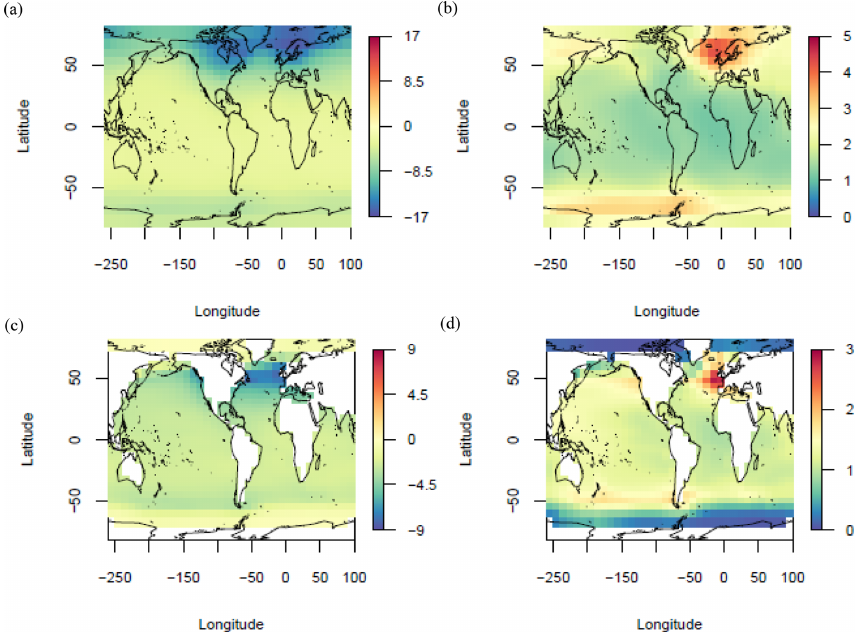
Figure 3. LGM change in surface air temperature (a–b) and sea surface temperature (c–d) ( ◦ C) ENS 104 mean (a, c) and standard deviation (b, d) .